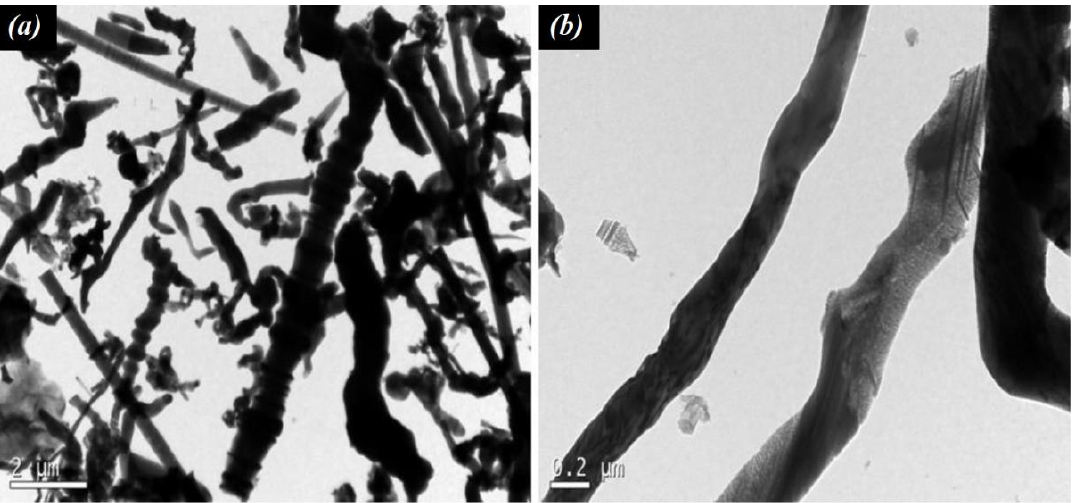
Figure 1. TEM images of the raw SiC NWs used. ( a ) 2 µm range, ( b ) 0.2 µm range. Ordinary Portland cement (OPC) and polycarboxylate-based (PCE) superplasticizer (SP) were used for paste production. The detailed composition of the pastes